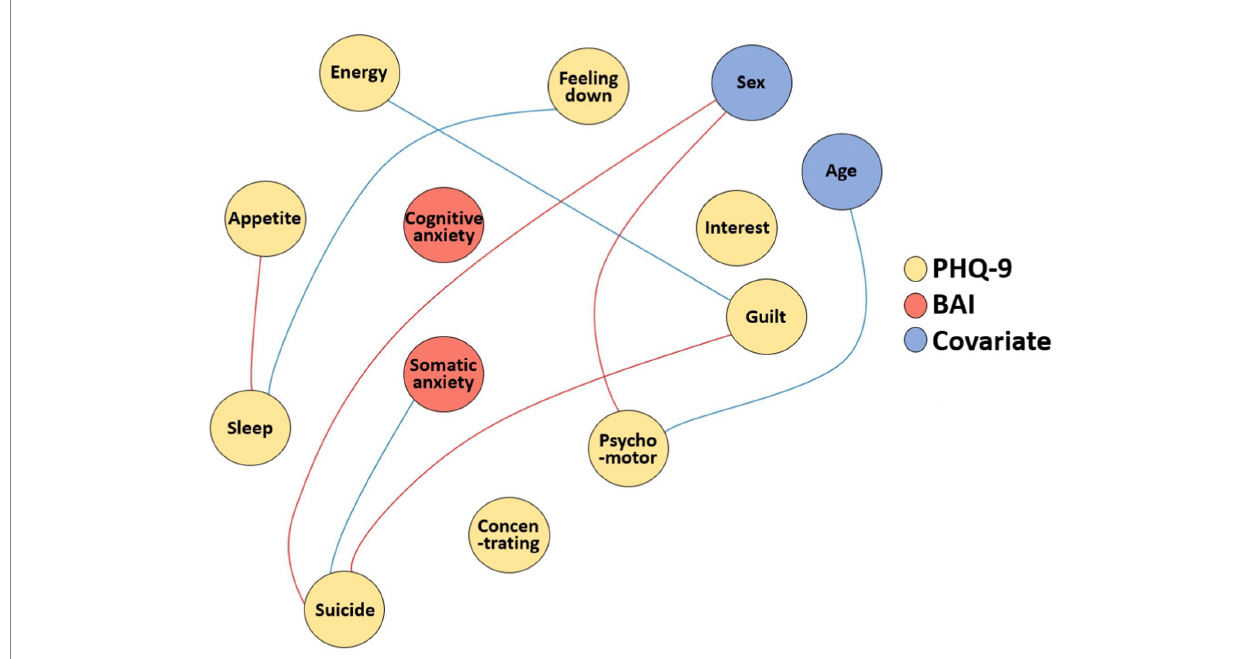
FIGURE 3 Network invariance test of the network of depression and anxiety before and during the pandemic BAI_Som, somatic subscale of the Beck Anxiety Inventory; BAI_Cog, cognitive subscale of the Beck Anxiety Inventory; Feeling down, item 1 of the Patient Health Questionnaire-9 (PHQ-9); Interest, item 2 of the PHQ-9; Sleep, item 3 of the PHQ-9; Appetite, item 4 of the PHQ-9; Psychomotor, item 5 of the PHQ-9; Energy, item 6 of the PHQ-9; Guilt, item 7 of the PHQ-9; Concentrating, item 8 of the PHQ-9, Suicide, item 9 of the PHQ-9. The blue edges indicate significantly increased partial correlations, and the red edges indicate significantly decreased partial